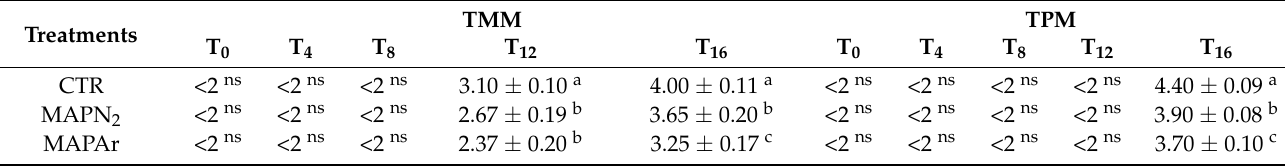
Table 5. Total mesophilic (TMM) and psychrotrophic bacterial (TPM) loads of the fruit samples treated with MAP (CTR: 20.9% O 2 + 0.04% CO 2 (passive-MAP); MAPN 2 : 10% O 2 + 5% CO 2 + 85% N 2 ; MAPAr: 10% O 2 + 5% CO 2 + 85% Ar). Units are log CFU/g. Results indicate mean values ± SD. Different letters indicate statistical differences ( p ≤ 0.05) between treatments for the same storage times. Letter “a” denotes the highest value, “ns” denotes no significant difference. Values were recorded at 0 (T 0 ), 4 (T 4 ), 8 (T 8 ), 12 (T 12 ), and 16 (T 16 ) days at 4 ± 1 ◦ C and 90 ± 5%